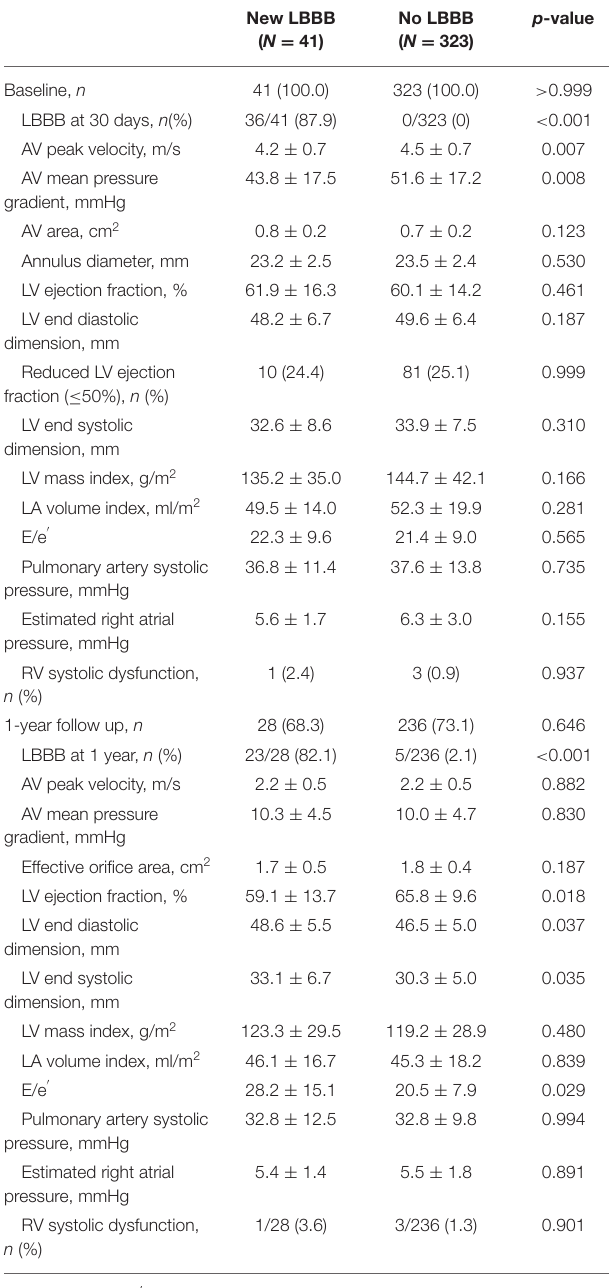
TABLE 2 | Echocardiographic